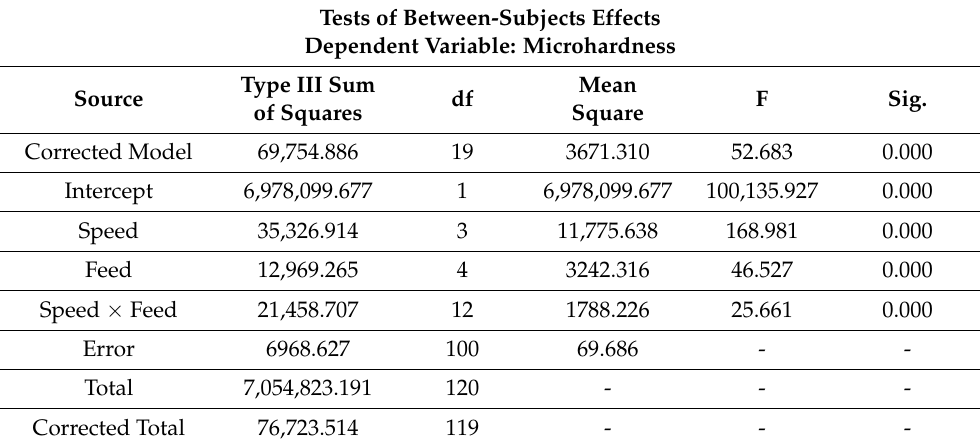
Table 2. SPSS outcome for univariate analysis of variance of microhardness. Tests of Between-Subjects Effects